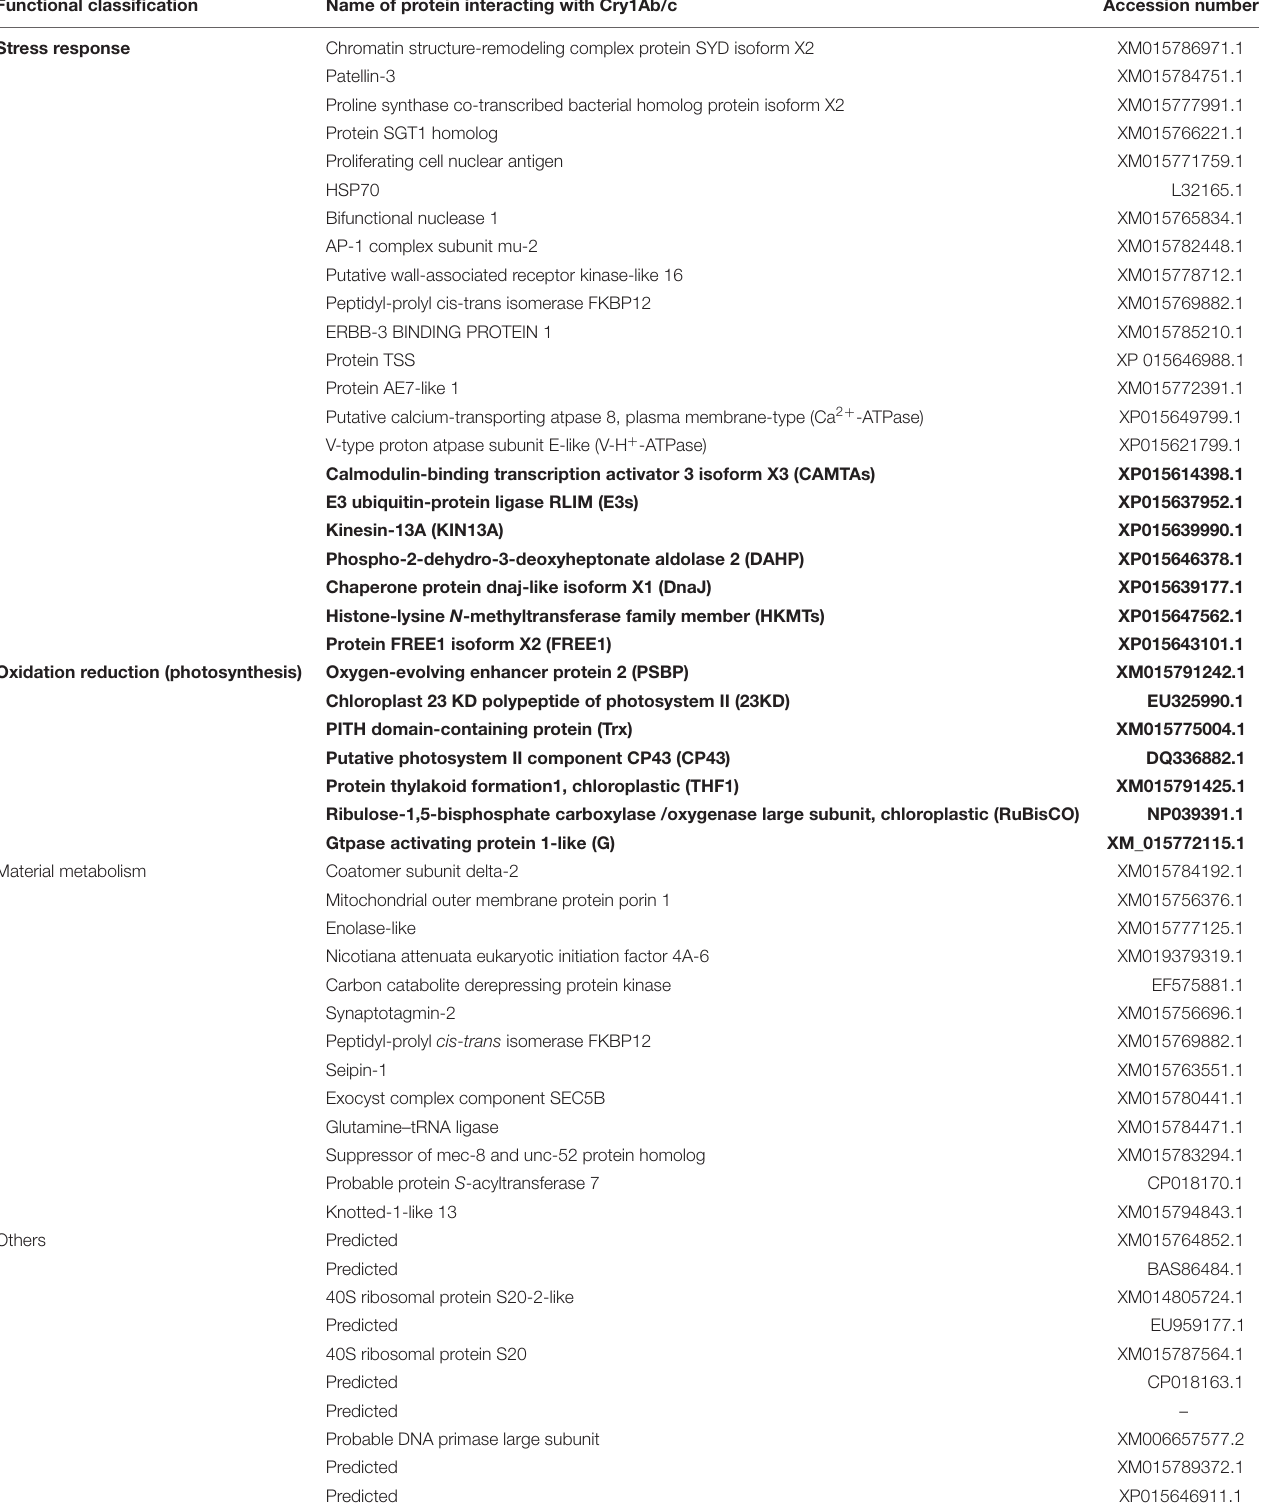
TABLE 1 | Detailed gene names and reference numbers of positive clones that are interacting with the Cry1Ab/c protein. Functional classification